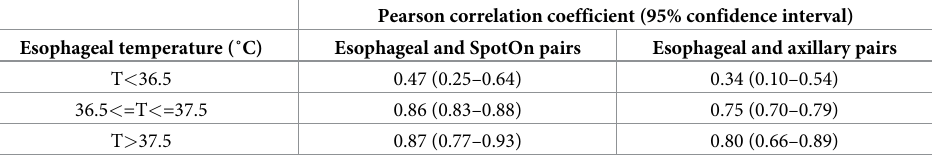
Table 3. Correlation analysis of esophageal temperature and SpotOn sensor, and esophageal temperature and axillary temperature divided by esophageal